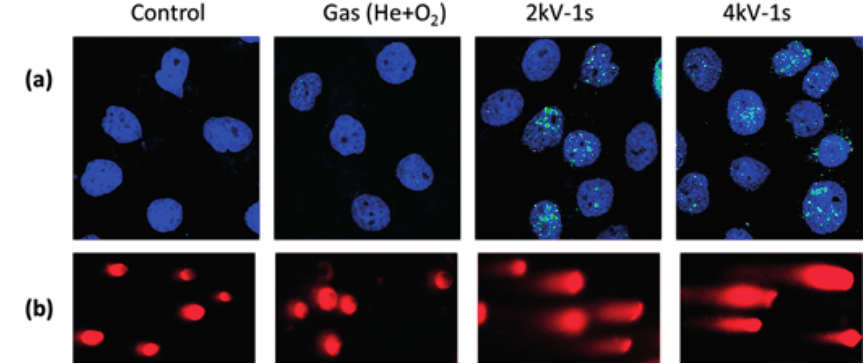
Figure 13. Effect of APP on DNA damage in SCC25 oral cancer cells. ( a ) Immunocytochemistry of γ -H2AX; SCC25 cells treated with 2 and 4 kV of NTP for 1 s showed increased γ -H2AX staining 24 h after APP treatment, indicating DNA damage; ( b ) Comet assay; cells containing DNA breaks (with long tails) were observed by fluorescence microscopy and quantified according to tail length, representing the extent